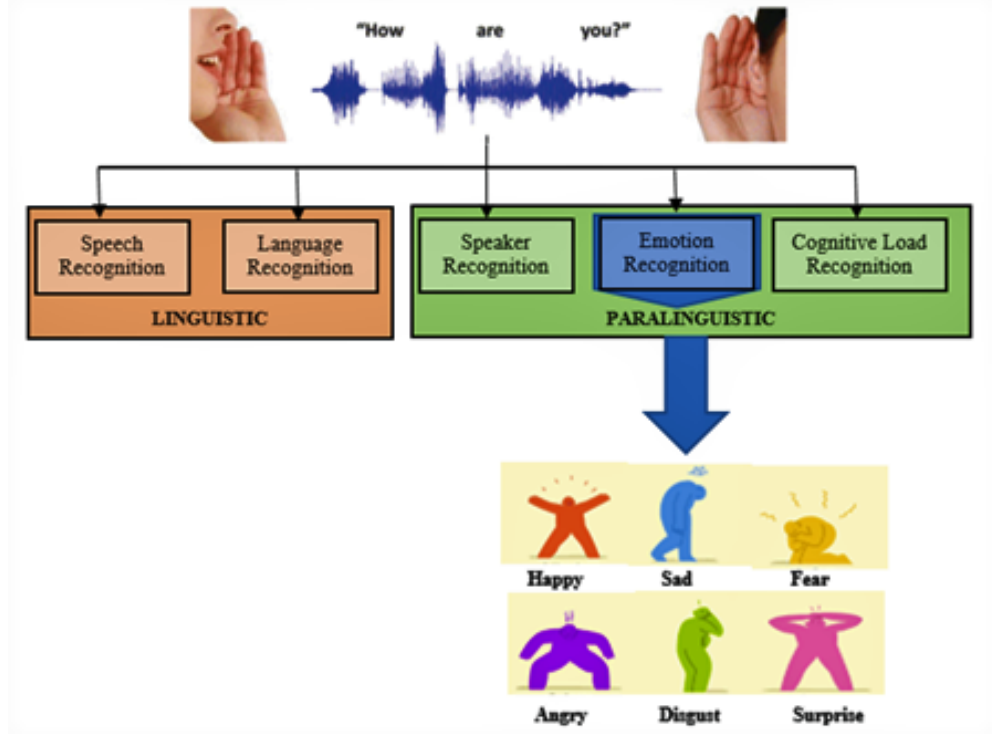
Figure 1. Emotion Classification